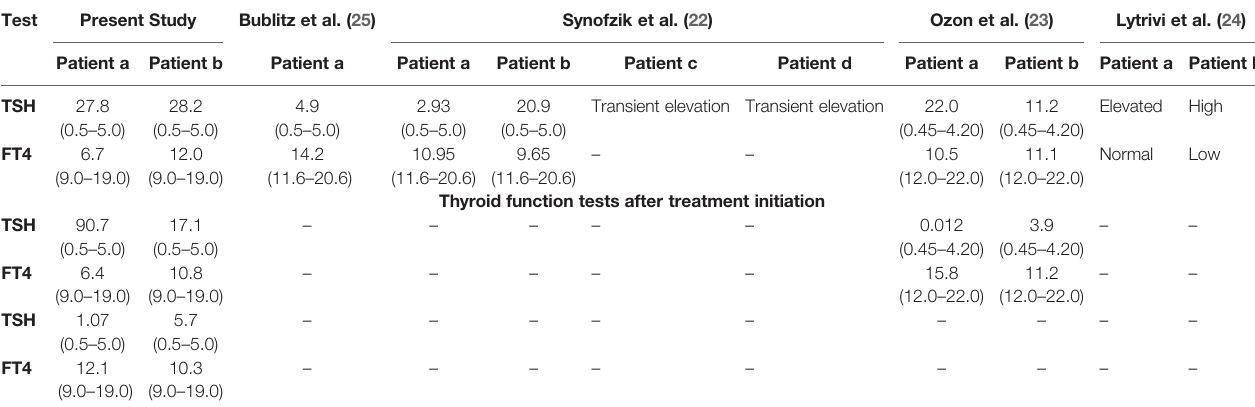
TABLE 1 | Thyroid function tests in individuals with homozygous DNAJC3